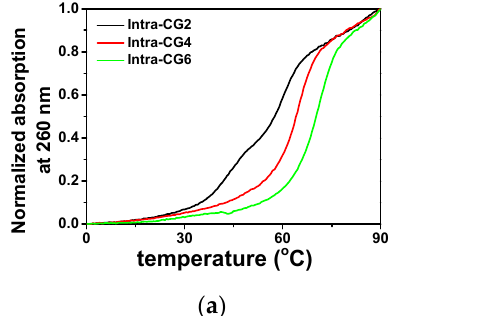
intermolecular triplexes in a buffer containing 50 mM MES and 0.1 M KCl at pH 6.0 in the absence of triplexes in a bu ff er containing 50 mM MES and 0.1 M KCl at pH 6.0 in the absence of PEG